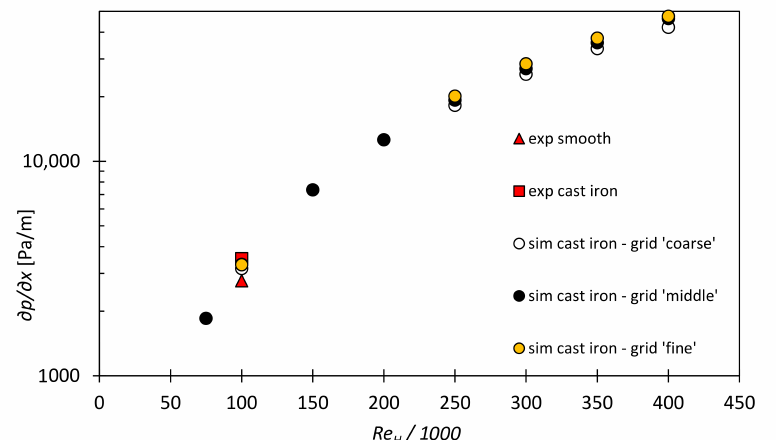
Figure 18. Experimentally and numerically assessed pressure gradients in the channel flows with the cast iron surface. Furthermore, an experimental value of a smooth channel flow at Re H = 100,000 was added to show the ability of the DPM to model the roughness effects in the channel. Please note: the measurement uncertainties of the pressure measurements are not displayed but were less than 1% of the mean values.